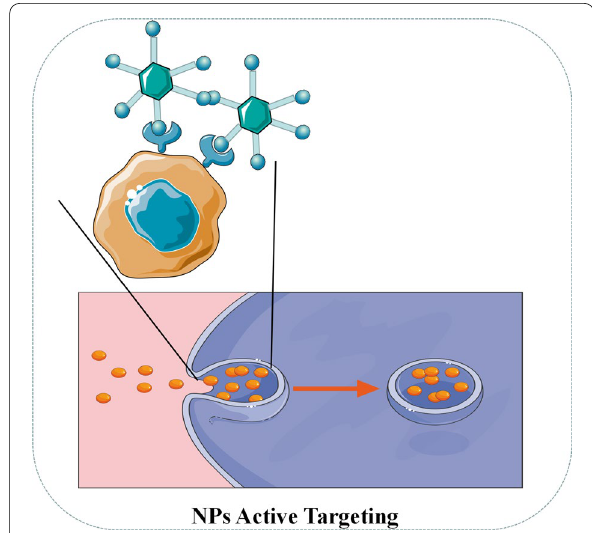
Fig. 4 Diagrammatic illustration of active targeting of